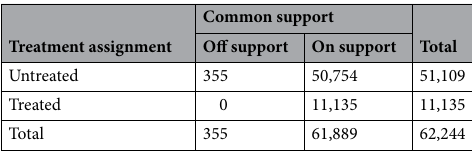
Table 5. Common support.